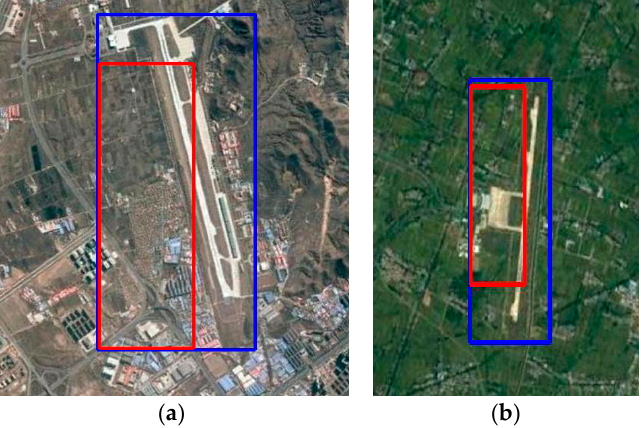
Figure 4. Low quality positive samples: ( a ) Zhangjiakou Ningyuan airport; ( b ) Yangzhou Taizhou airport. The bounding box of the airport is shown by the blue rectangle, and the low quality positive sample is shown by the red rectangle. [Image courtesy of Google Earth].